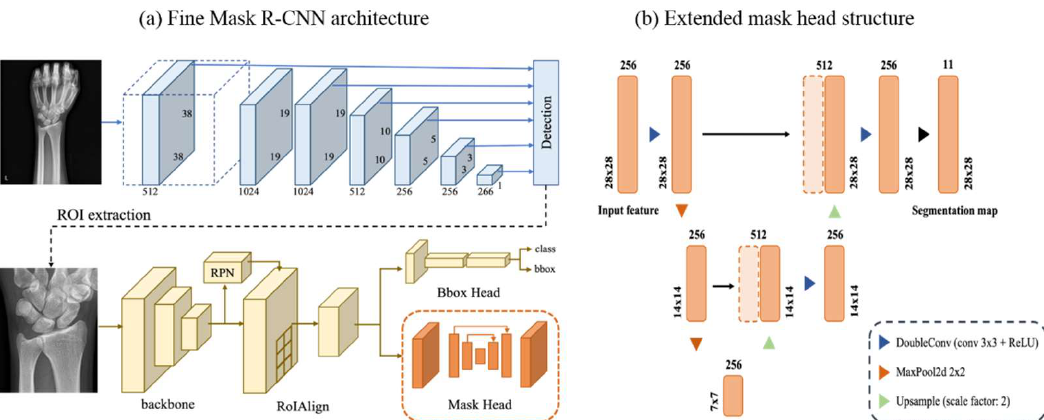
Figure 2. The Fine Mask R-CNN architecture. Our proposed network operates on a 2-stage method. ( a ) Detection of the regions of interest in the input wrist radiographs using SSD (blue) in the first stage and the delineation of 10 wrist bones using Mask R-CNN with the extended mask head in the second stage (yellow). ( b ) The structure of the extended mask head. This is an encoder–decoder structure, which can use previous information for the prediction of a specific part. ROI, region of interest; CNN, convolutional neural networks; SSD, Single-Shot Multibox Detector.